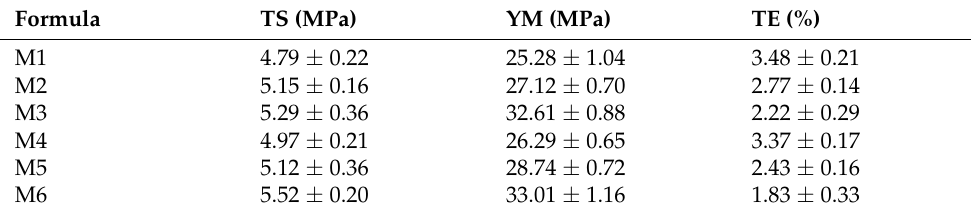
Table 3. Mechanical characterization of the pellets produced.